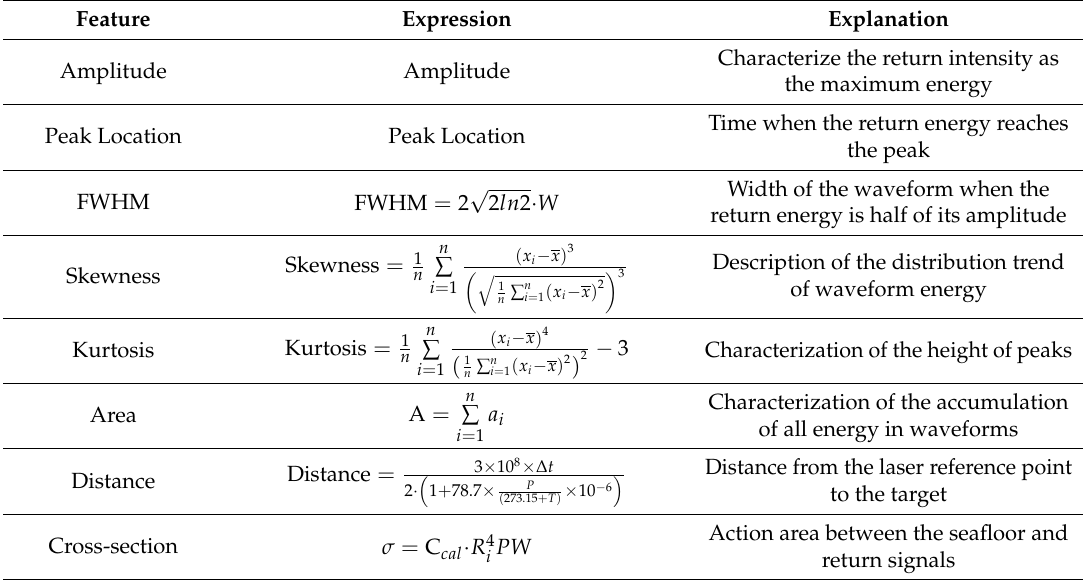
Figure 1. Schematic of Gaussian fitting: the dark blue curve represents the raw waveform, the blue curve represents the Gaussian fitting, and the red dotted line represents the generalized Gaussian fitting. Table 1. Expressions and explanations of light detection and ranging (LiDAR) features. FWHM, full width at half maximum.